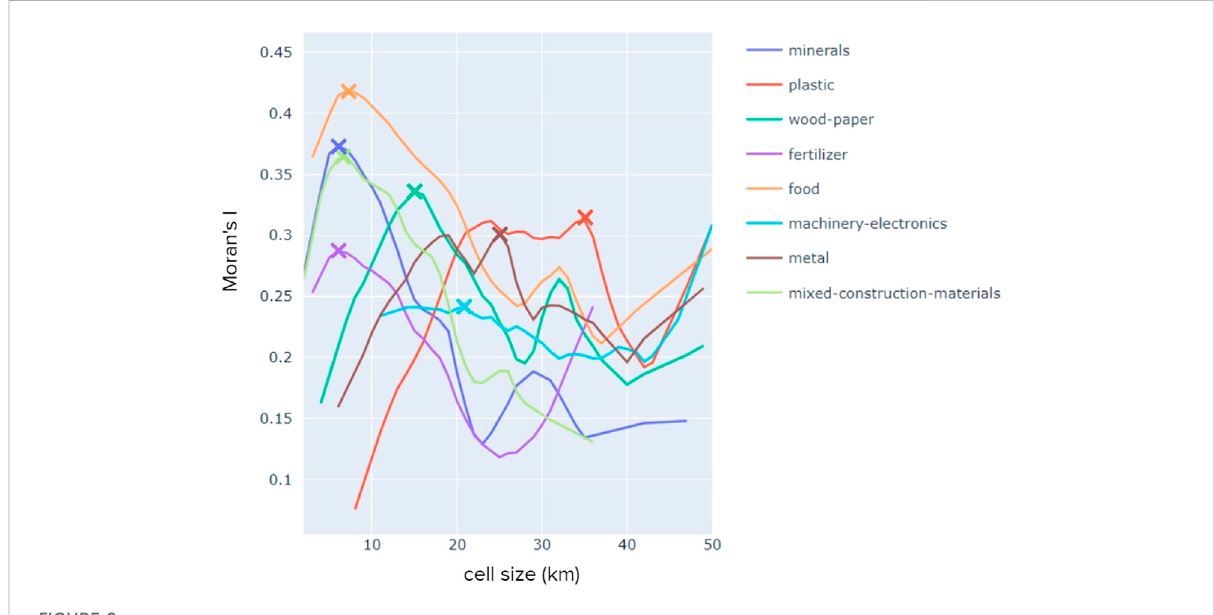
FIGURE 8 Effect of cell size on Moran ’ s I value for all materials, created by authors.